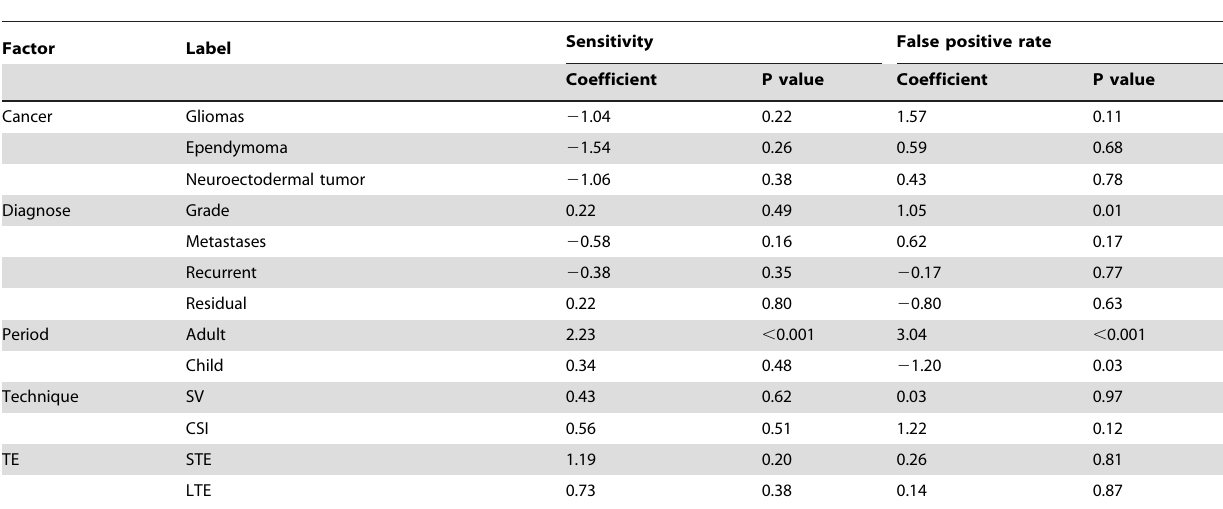
Table 3. Meta-regression of potential risk of bias of methodological characteristics affecting the diagnostic sensitivity of MRS.